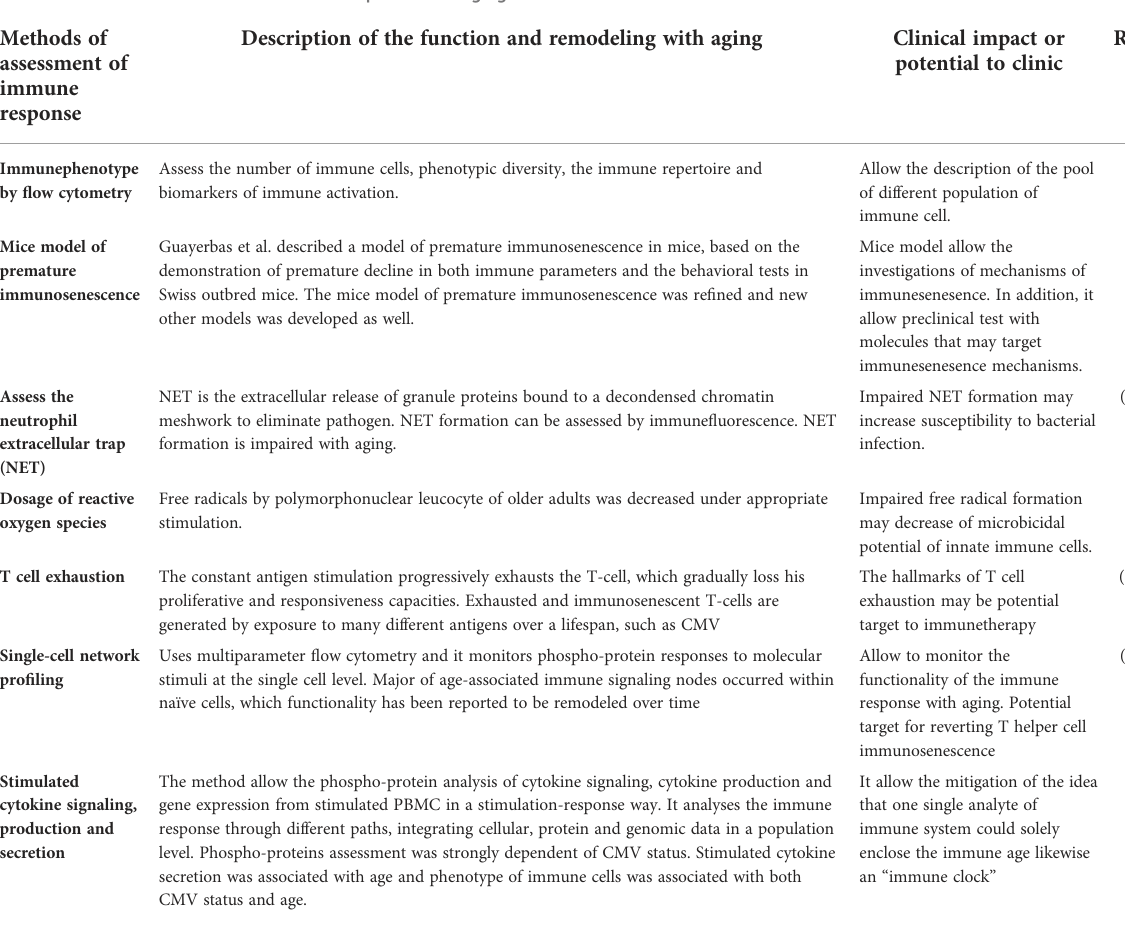
TABLE 2 The assessment of the immune response with